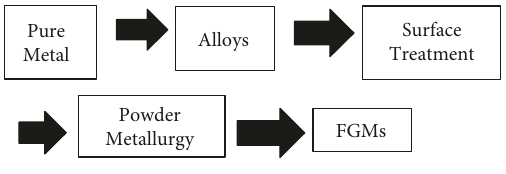
Figure 1: FGM production process.